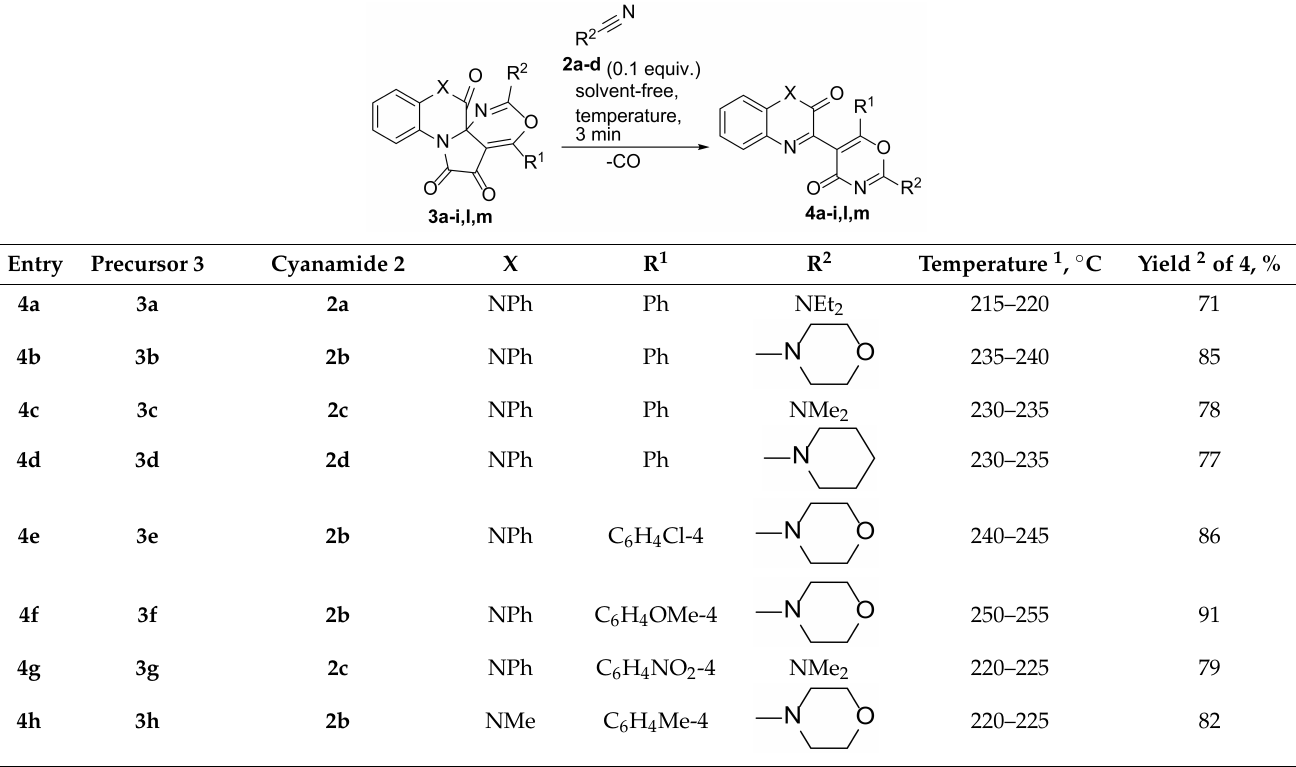
Table 2. Thermal decomposition of compounds 3a–j,l,m